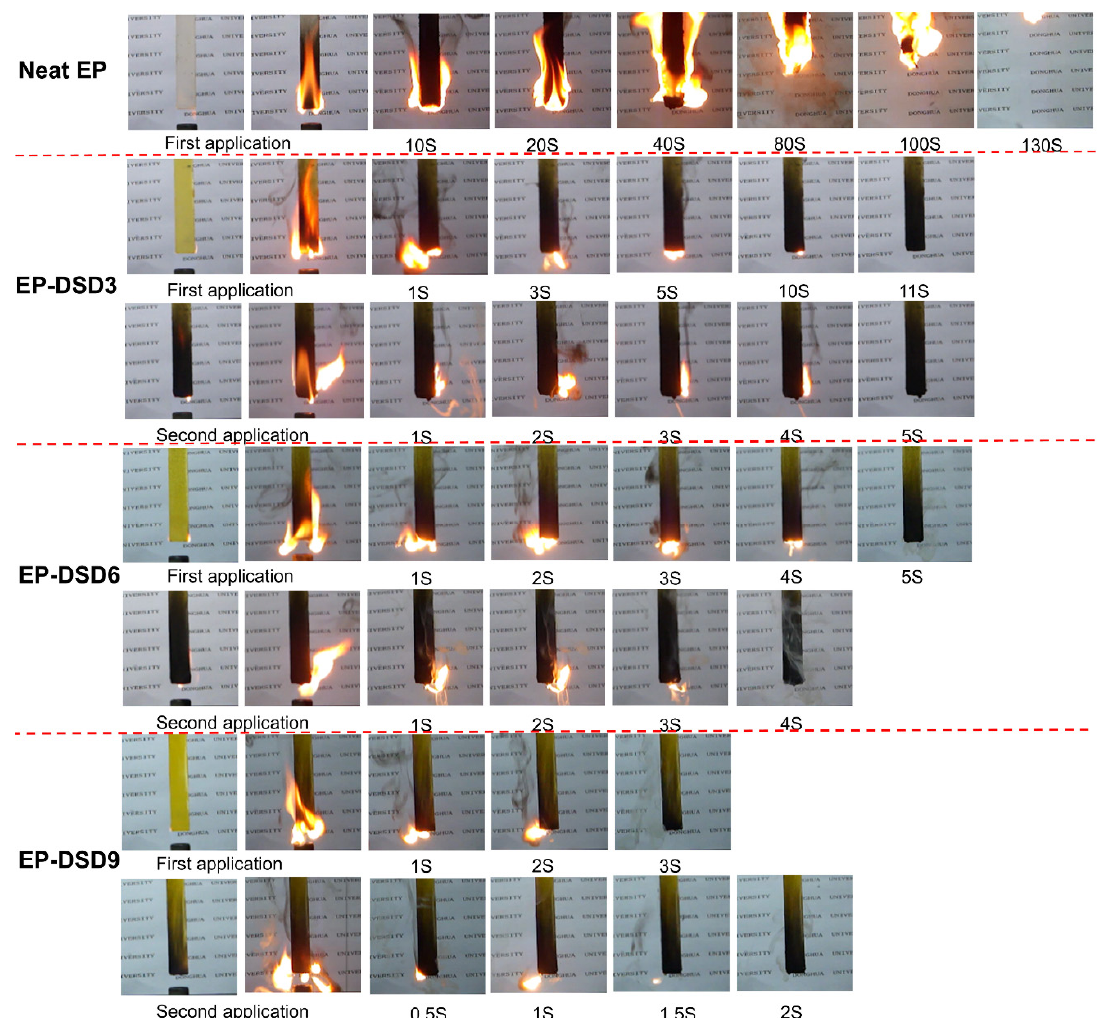
Figure 3. Digital photos of EP thermosets during the UL-94 test.